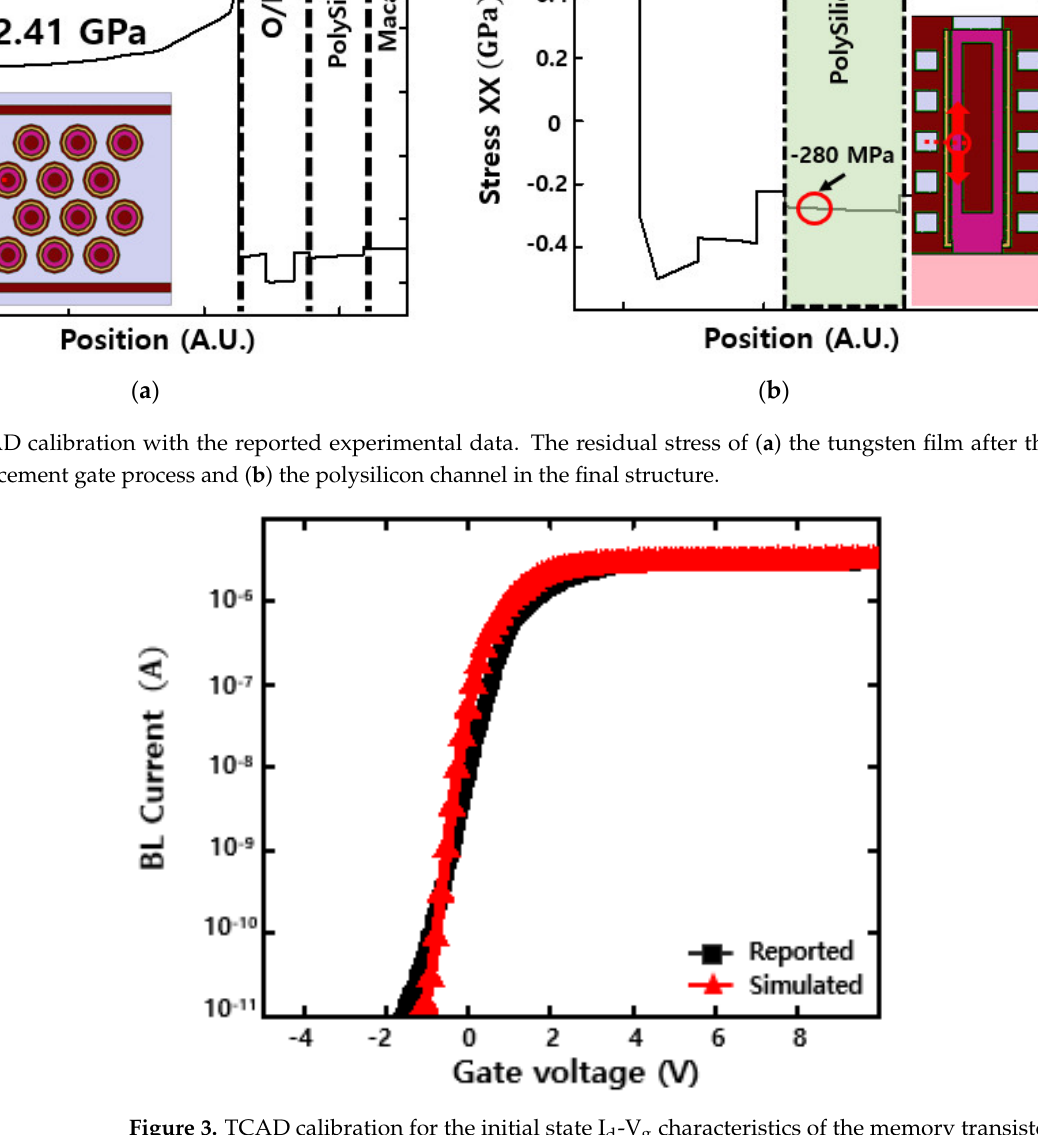
Figure 3. TCAD calibration for the initial state I d -V g characteristics of the memory transistor with the reported data